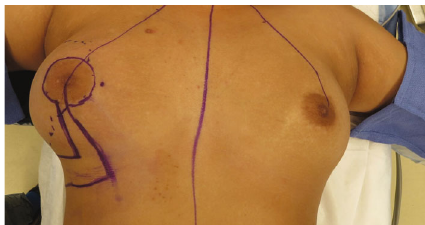
Figure 1: Preoperative image capturing prominence of tumor size and breast distortion relative to contralateral breast.